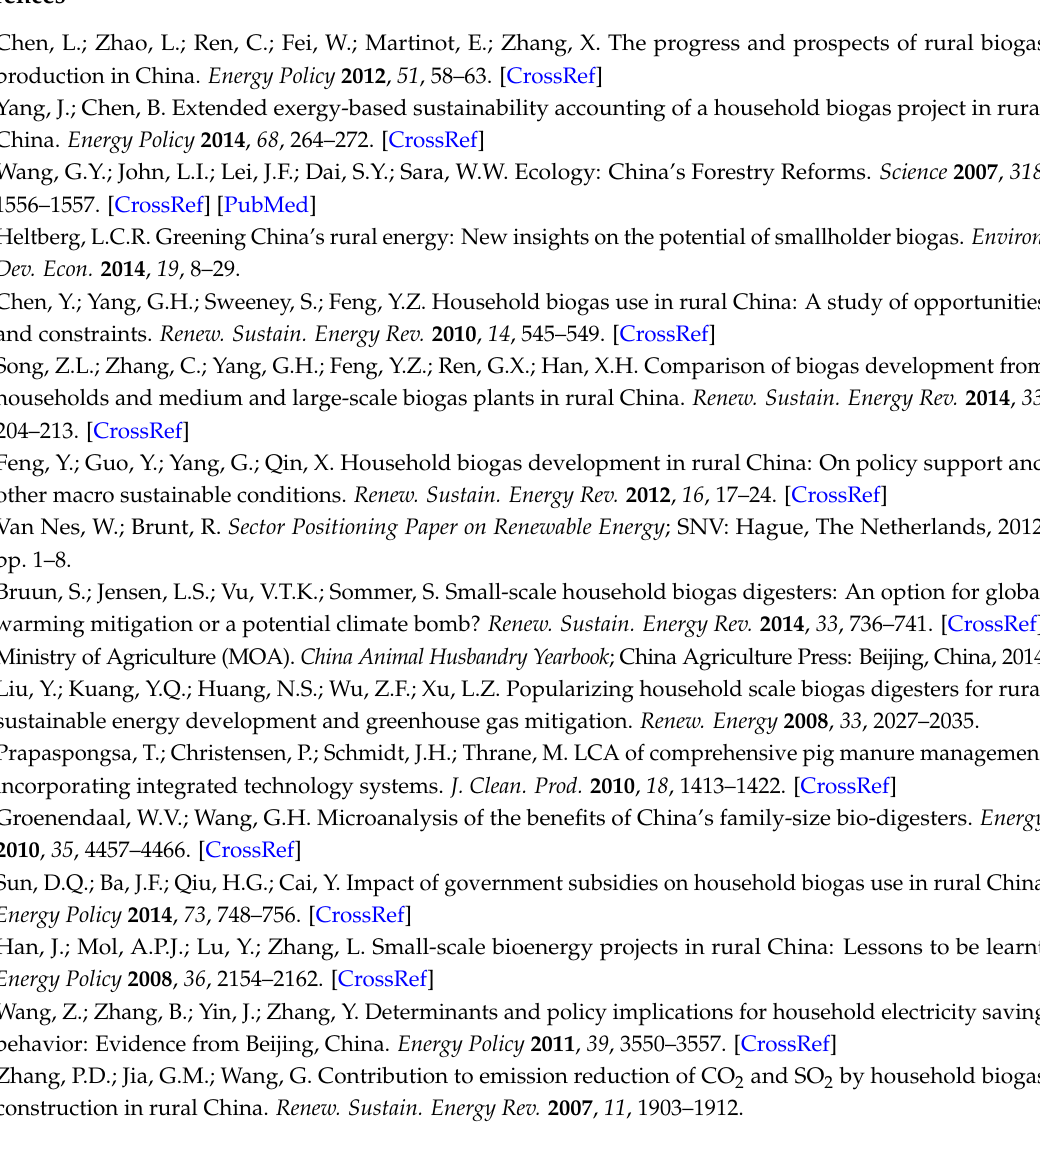
Table S1: The numbers of biogas and non-biogas farms and main categories in the survey, Table S2: GHG emission factors for manure management, Table S3: Calculation parameters of energy consumption, Table S4: GHG emission factor of energy consumption, Table S5: GHG emission factors of energy extraction and transportation, Table S6: Contents of nutrients in manures, digestate and wastes, Table S7: Nutrient retention of biogas digesters in the two villages, Table S8: GHG emission during chemical fertilizer production and transportation, Table S9: The estimated biogas yields of households, Table S10: Cropland and livestock, Table S11: Nutrient content of different crop straws, Table S12: Manure treatment in Zhu and Shu in 2009/2010, Table S13: Household income and average years of education completed by the head of the household, Table S14: Energy consumption by source in biogas and non-biogas households in the two villages in 2009/10, Table S15: Estimated energy consumption of all households including biogas and non-biogas farmers in 2009/10, Table S16: Fertilization of biogas and non-biogas household in two villages in 2009/10, Table S17: Straw use in different ways of the two groups of farmers in 2009/10, Table S18: Straw nutrient content and use in